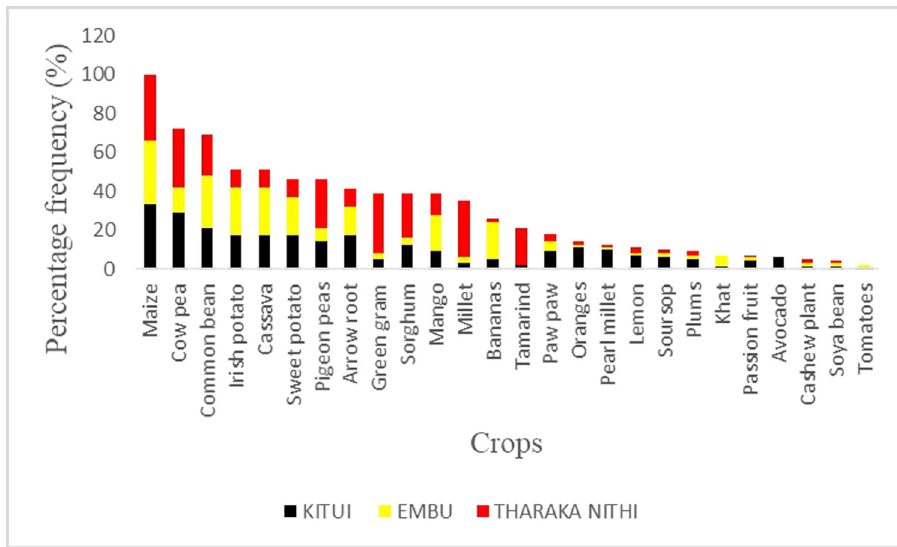
Figure 3: Di ff erent types of crops grown by farmers in the study area. Legumes and cereals were the dominant crop types. Bananas, mangoes, and tubers were the other crops grown by farmers in all the three counties. Tomatoes were only reported in Embu County, while avocado farming was reported only in Kitui